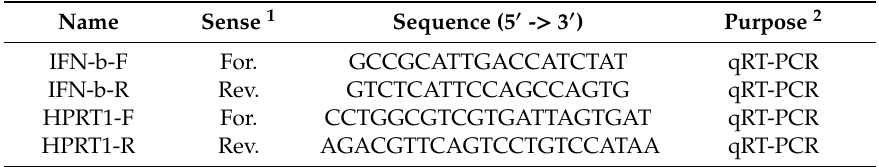
Table 2. List of primers used for Real-time quantitative reverse transcription PCR (qRT-PCR). Name Sense 1 Sequence (5 (cid:48) - > 3 (cid:48) ) Purpose 2